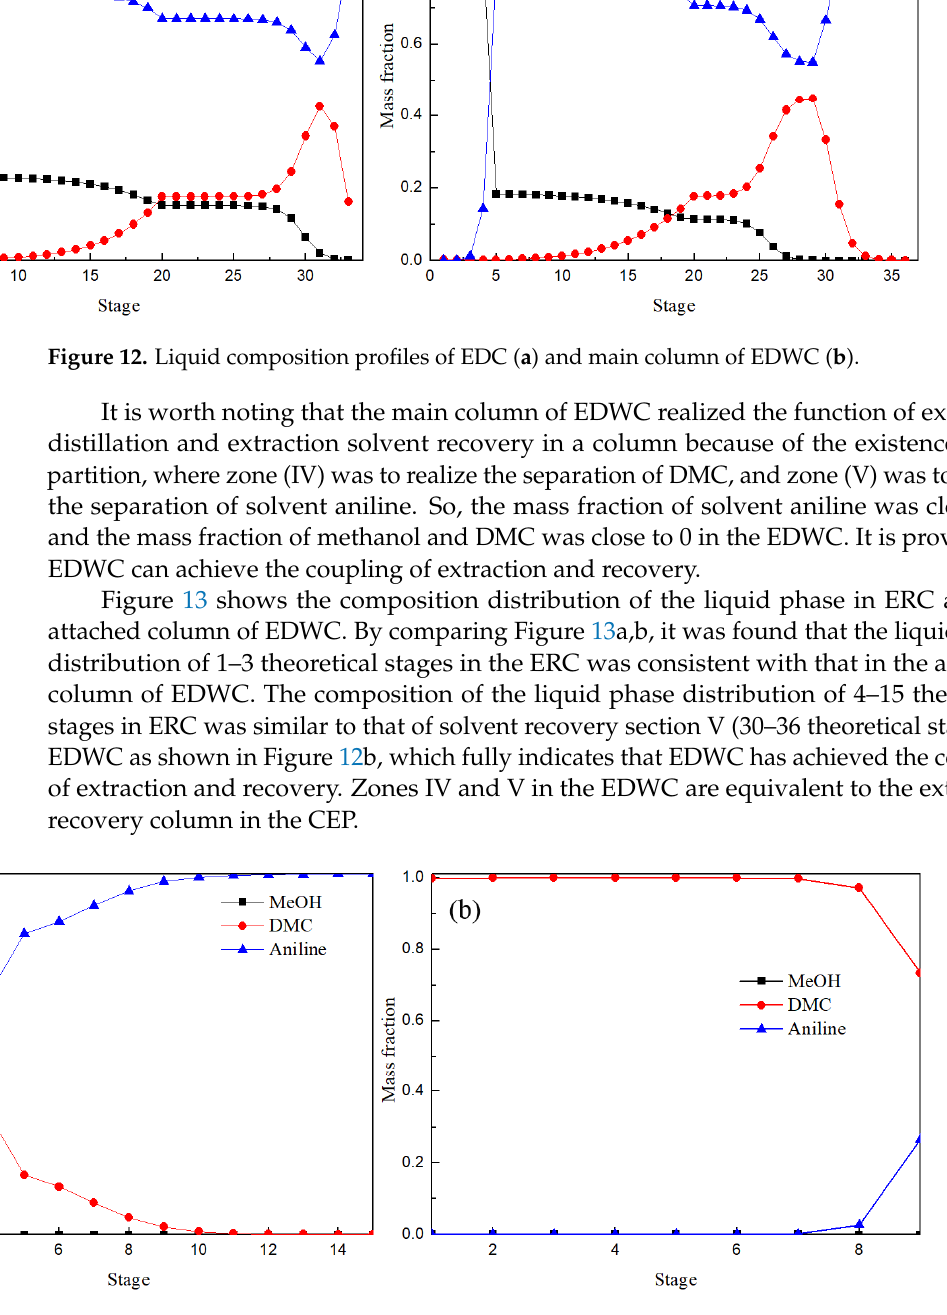
Figure 13. Liquid composition profiles of ERC ( a ) and attached column of EDWC ( b ).